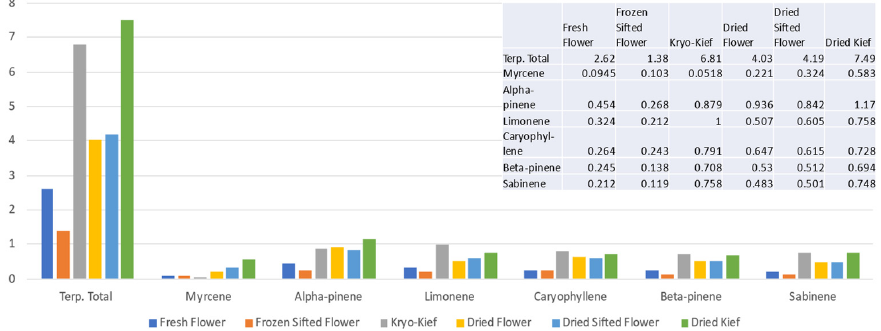
Figure 2. Doug Fir Type I chemovar terpenoid assay results (all figures are %).